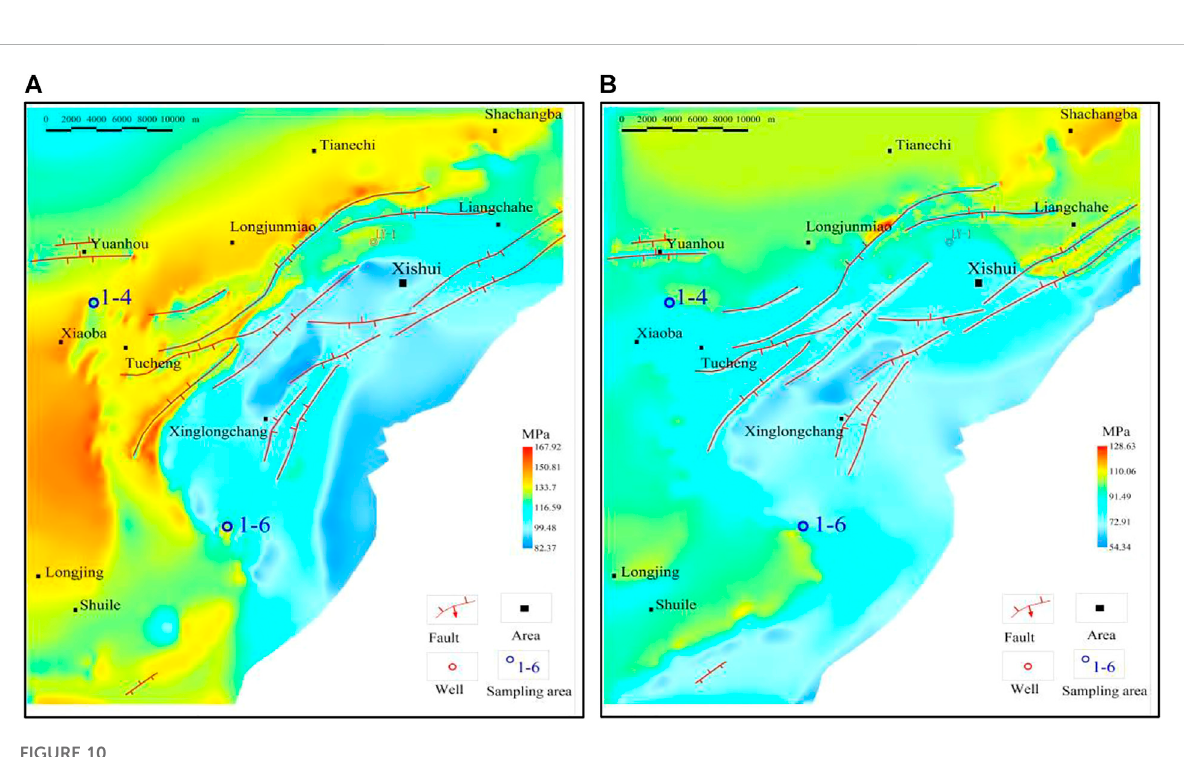
Frontiers in Earth